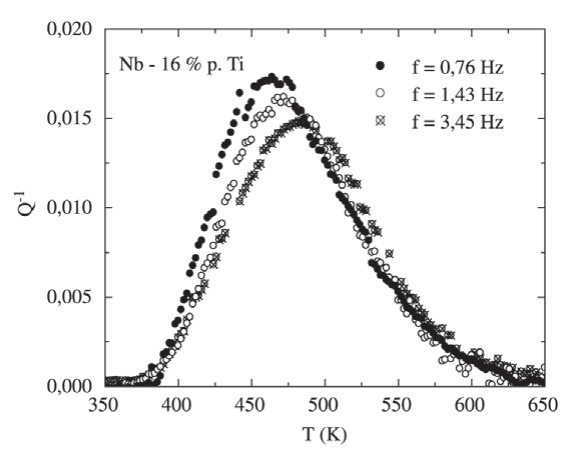
Figura 2. Influência da freqüência na estrutura de relaxação anelástica observada na amostra da liga Nb-16% p. Ti contendo oxigênio em solução